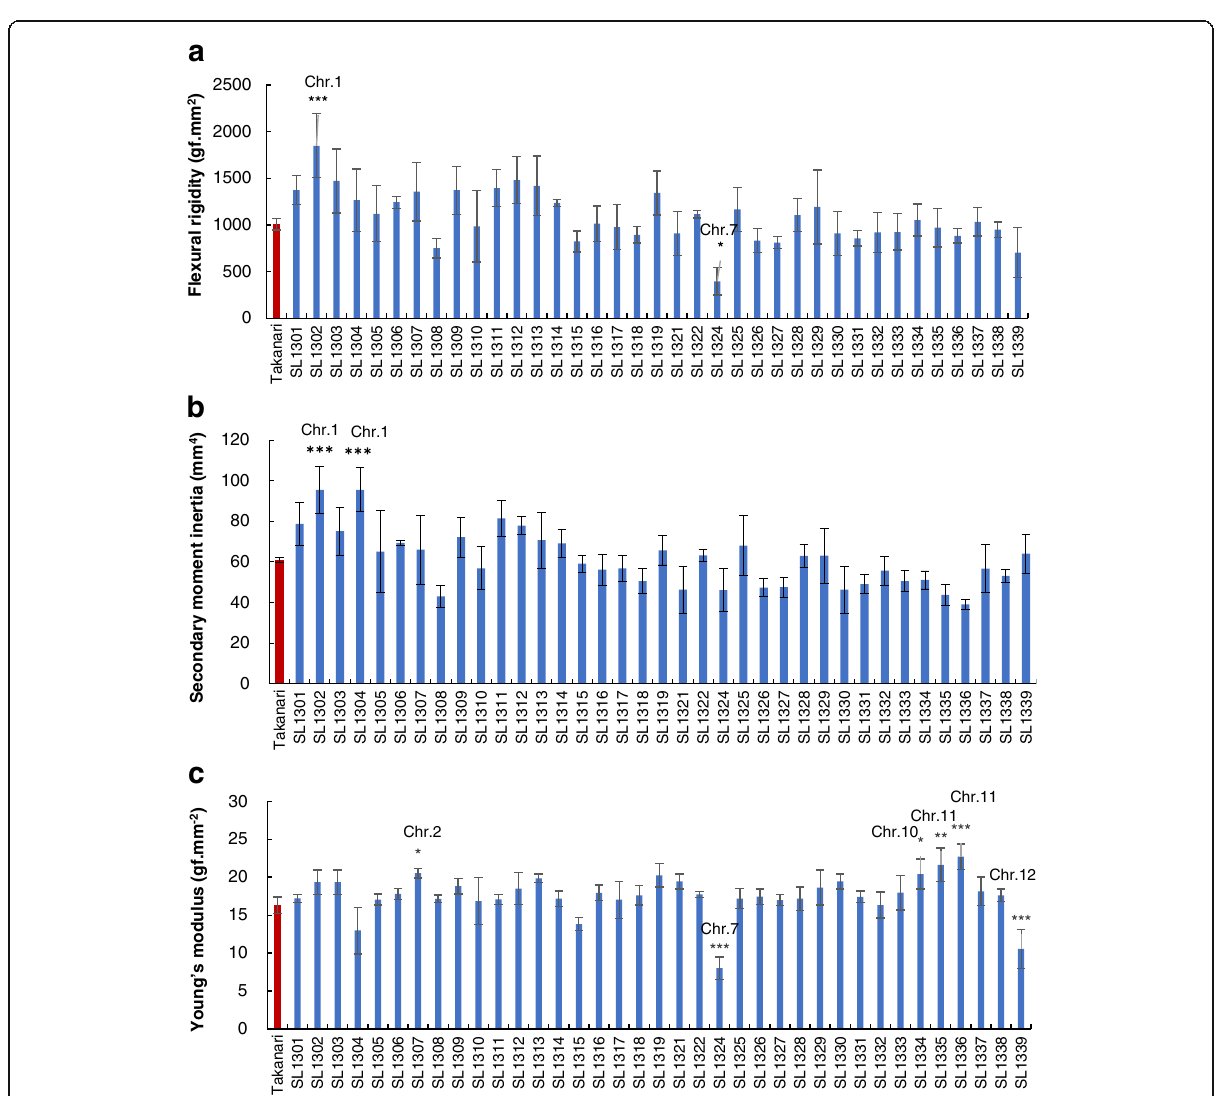
Fig. 2 Physical parameters associated with bending-type lodging resistance in T-CSSLs. a flexural rigidity, b secondary moment inertia, and c Young ’ s modulus of the fourth internode. Data are expressed as the mean ± SD. *, **, and *** represent significant differences at 5, 1, and 0.1% level,